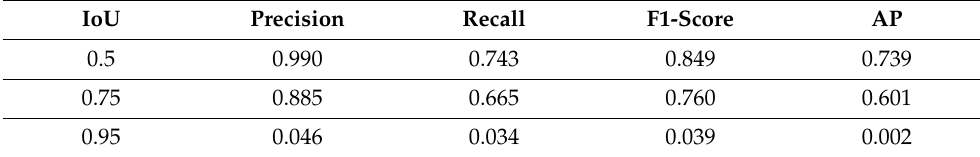
Table 3. Accuracy assessment of hat wearer detection results with Faster R-CNN.